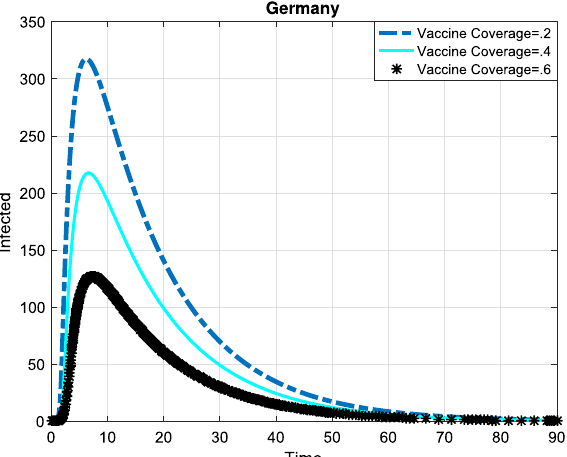
Figure 5. Simulation, the forecast of the epidemic process. Infected cases are predicted by the SMEIHRDV model in Germany. The results show that the number of infected cases at the epidemic peak is approximately 320 in Germany and it has reduced to 120 by the increasing vaccine coverage from 0.2 to 0.6. N = 80, 000, 000.